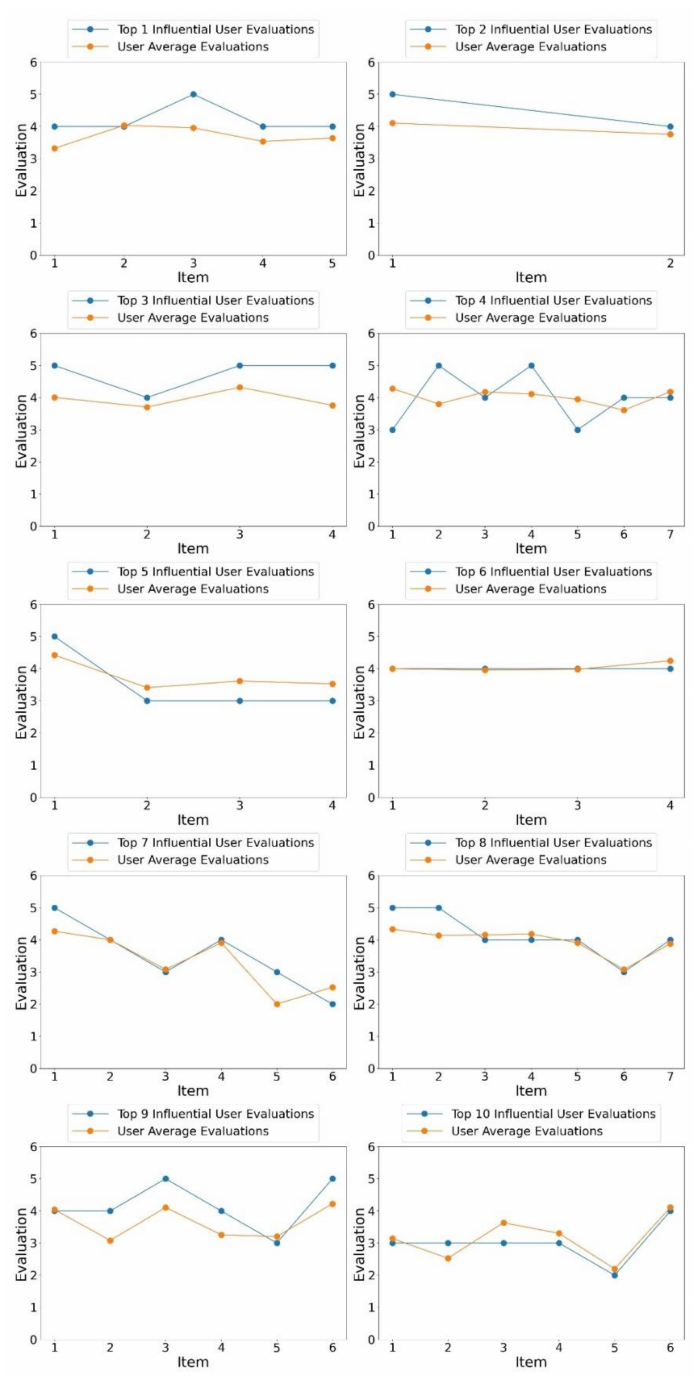
Figure 3. Comparison of the evaluations by the top 10 influential users with the average evaluations by all